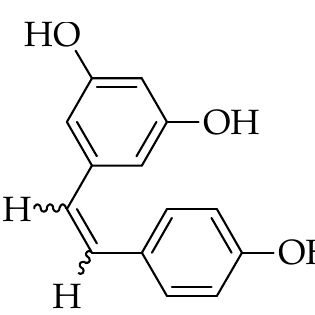
Figure 2. The chemical structure of resveratrol.